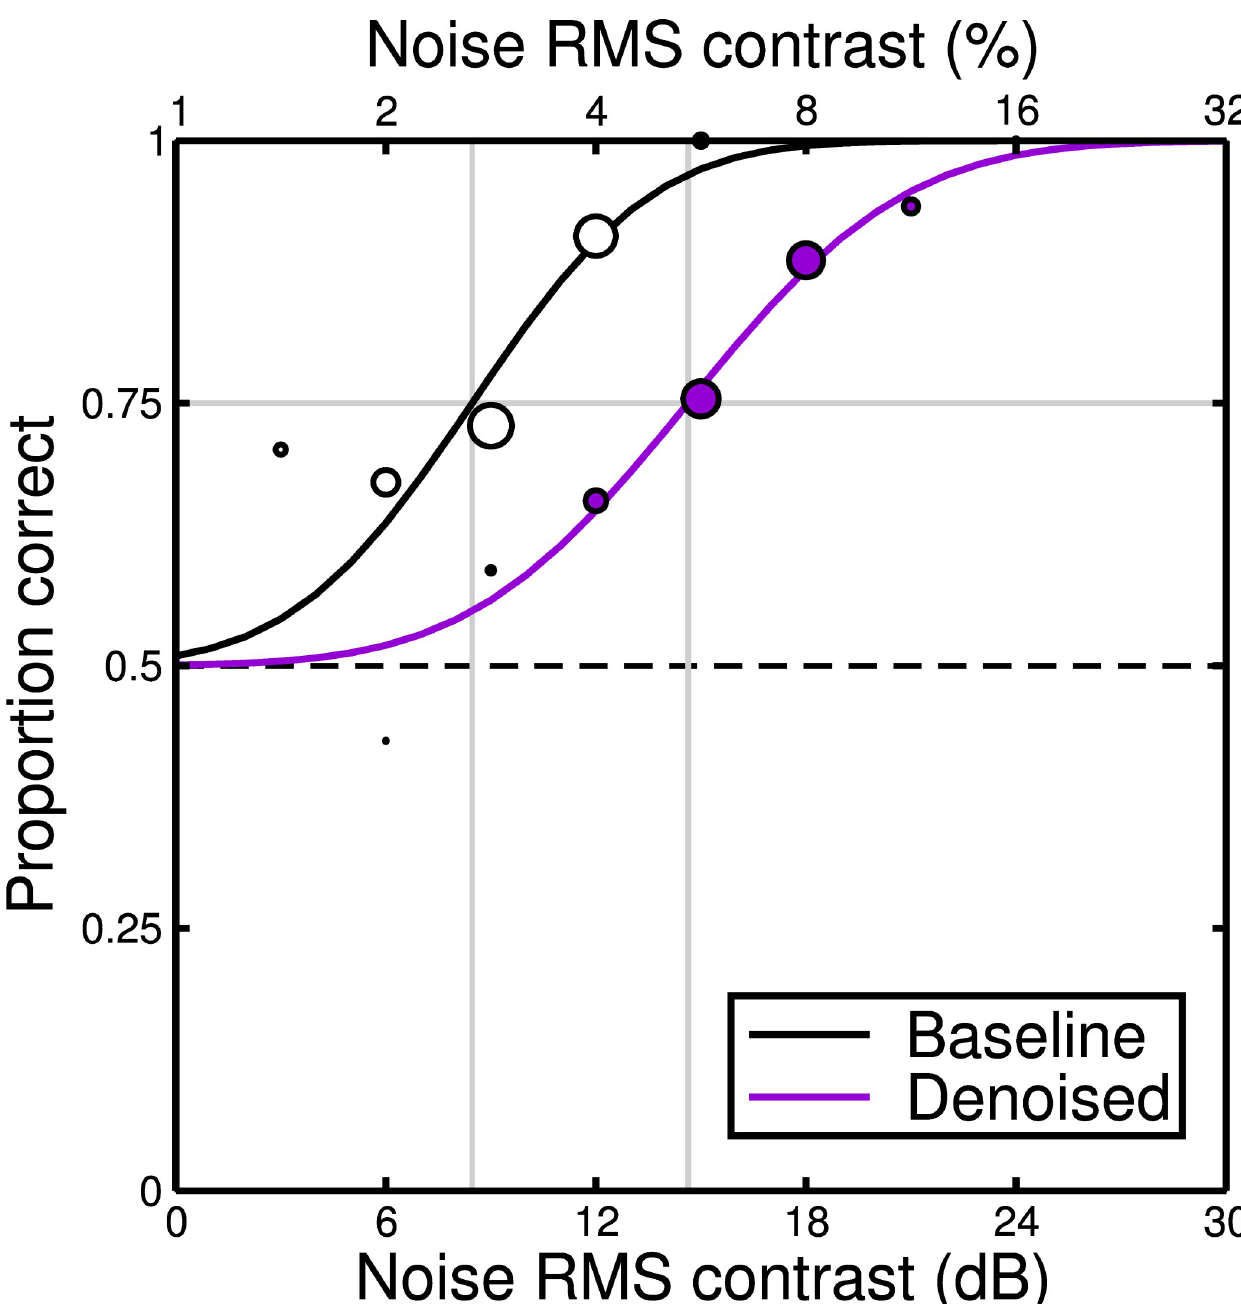
Fig 5. Example psychometric functions for observer DHB. Data points represent the proportion of trials on which the observer correctly identified the stimulus with added noise. The guess rate of 0.5 is given by the horizontal dashed line. Symbol size at each level is proportional to the number of trials. Curves are fits of the cumulative log-Gaussians, with vertical grey lines indicating the noise contrast at threshold performance (75% correct). In the Baseline condition (white symbols) the target was white pixel noise added to one of the images in the 2AFC pair. In the Denoised condition (purple symbols) the stimuli were the from the same set as at baseline, but after being passed through the denoising